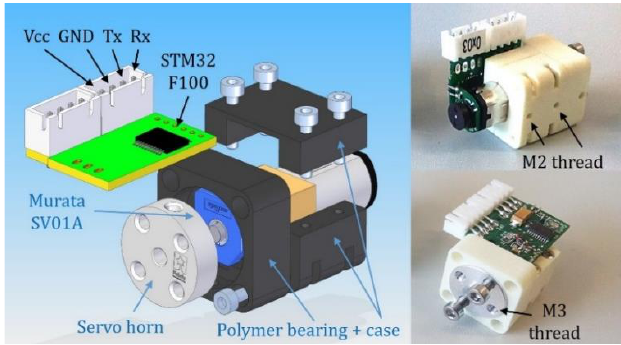
Figure 2. Customized micro-servo actuator based on Pololu micro-motor.